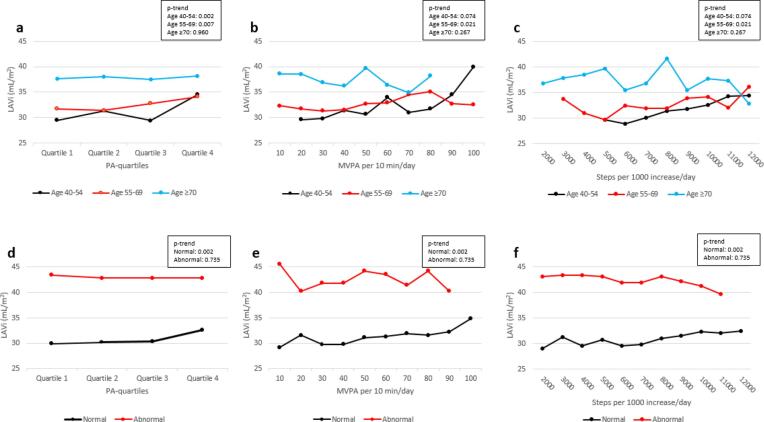
a-c show adjusted mean LAVi stratified by age and PA, and Fig. 1d-f show adjusted mean LAVi stratified by LV diastolic function and PA. Fig. 1a and 1d show mean LAVi for the PA-quartiles, where quartile 1 is least active and quartile 4 most active. Fig. 1b and 1e show mean LAVi for every 10 min increase in MVPA per day, and Fig. 1c and 1f show mean LAVi for every 1000 steps per day increase. Mean values were adjusted for sex, BMI, systolic blood pressure, diabetes, smoking, and LDL cholesterol. LAVi: left atrial volume index, PA: physical activity, MVPA: moderate-to-vigorous physical activity, BMI: body mass index, LDL: low-density lipoprotein. The Tromsø Study 2015–16.